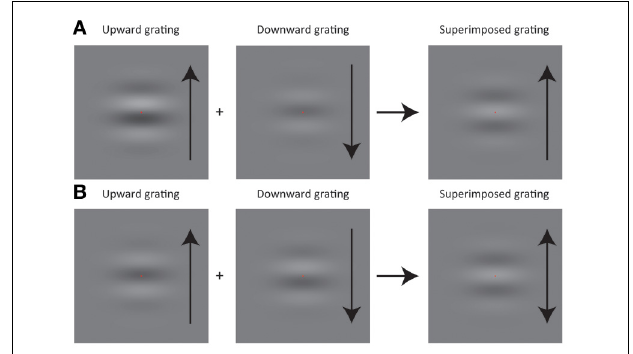
FIGURE 1 | Schematic illustrations of grating stimuli used in experiments. (A) When a high contrast upward (downward) grating is superimposed on a low-contrast downward (upward) grating, a percept of an upward (downward) grating results in. (B) If the contrast of an upward grating is equivalent to the one of a downward grating, a grating with ambiguous motion direction is perceived.